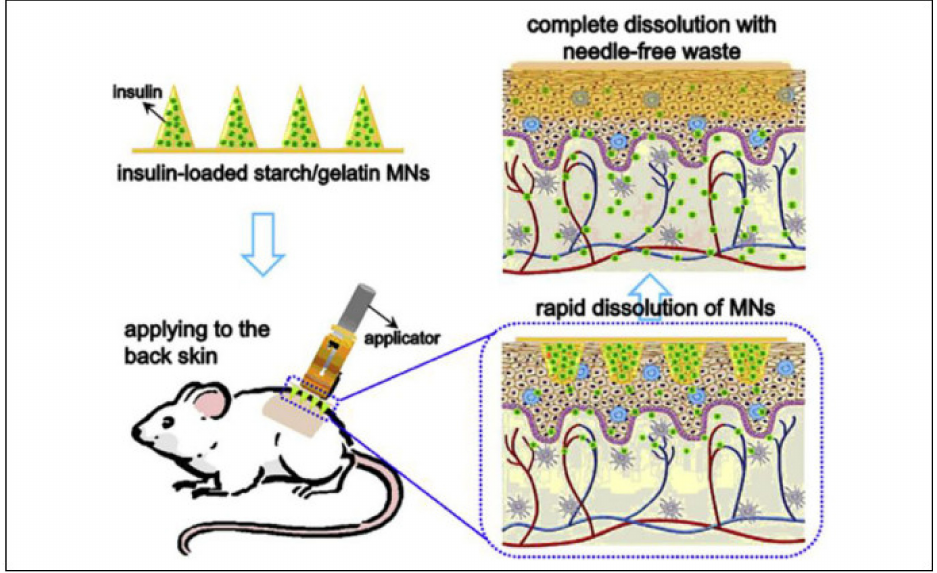
Figure 15. MNs for insulin delivery [237] (Reprinted with permission from Ref. [237]. Copyright 2013